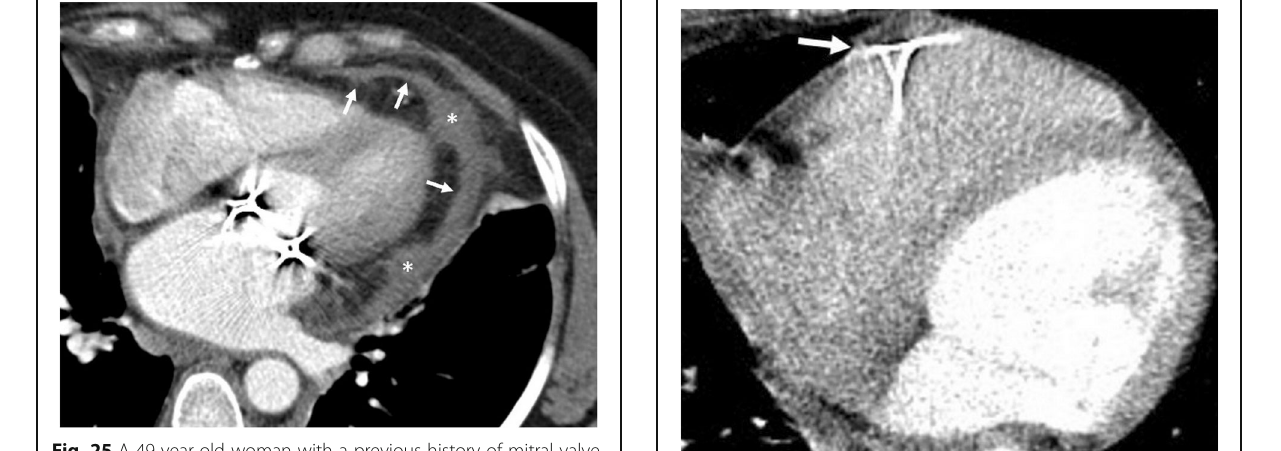
Fig. 25 A 49-year-old woman with a previous history of mitral valve replacement surgery. Axial contrast-enhanced CT image shows a pericardial effusion (arrows) with irregular and nodular margins (asterisks). Post-surgical adhesions can mimic imaging signs